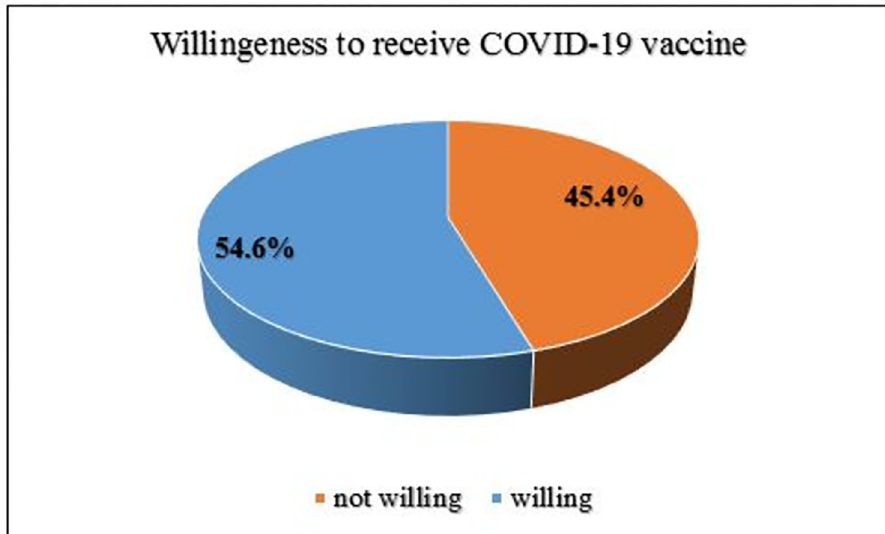
Fig 3. Chronic patient’s willingness to receive COVID-19